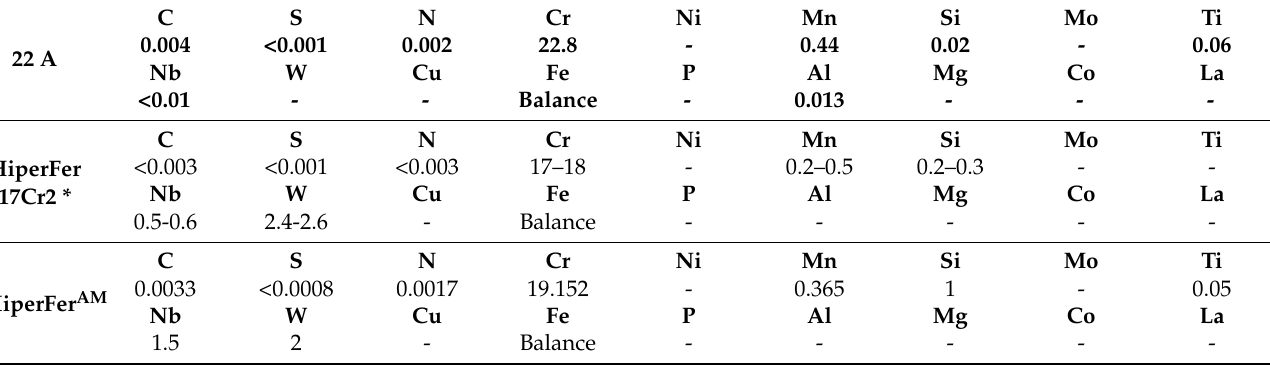
Table 1. Chemical compositions of Laves-phase-strengthened ferritic trial steels